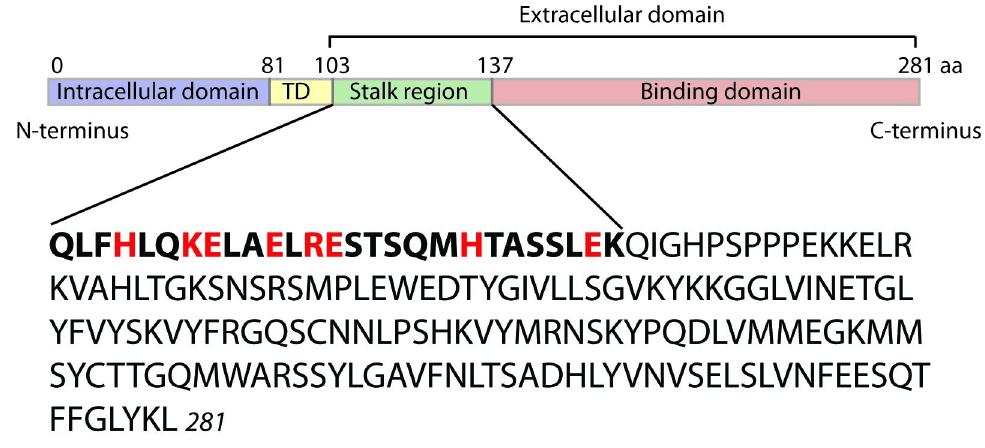
Fig 1. Fas ligand structure and modifications. Fas ligand is a 281 amino acid protein that contains an intracellular domain, a transmembrane domain (TD), a “stalk region”, and the binding domain. Fas ligand can be cleaved my metalloproteinases at amino acid 103 to form a soluble form that retains activity. Soluble Fas Ligand (sFasL) can be further cleaved at amino acid 128 into a “short” soluble form that is inactive. We mutated all the charged amino acids of the stalk region to non-charged alanines (shown in